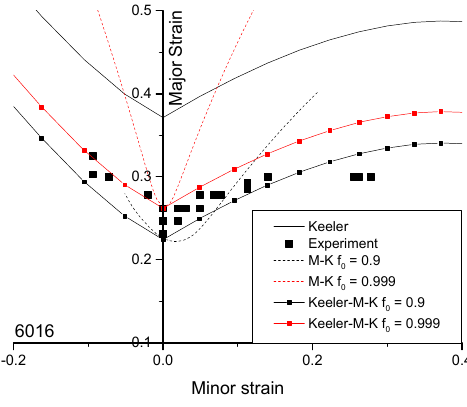
Figure 10. FLC for AA6016.